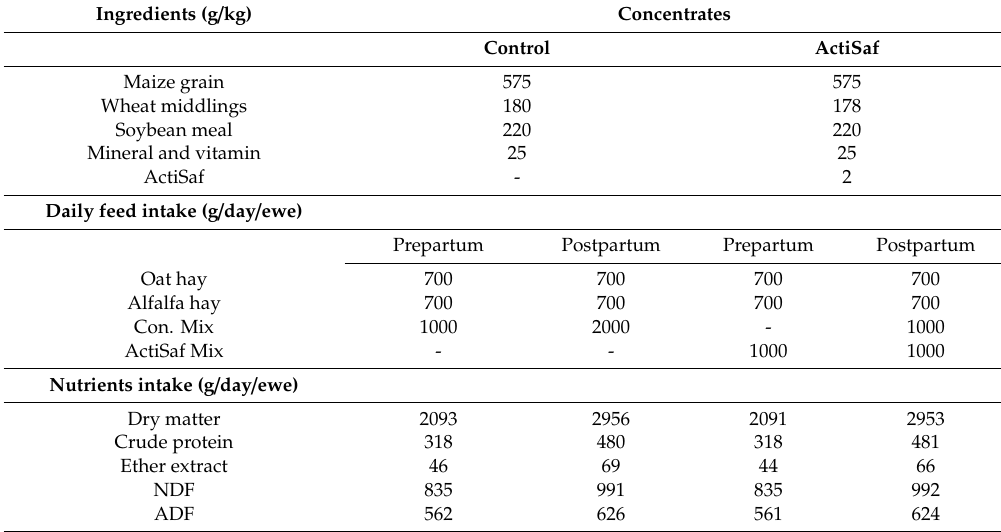
Table 1. Concentrates composition (g / kg), diet intake (g), daily nutrients intake (g / ewe), and feeds chemical composition and fatty acid profile